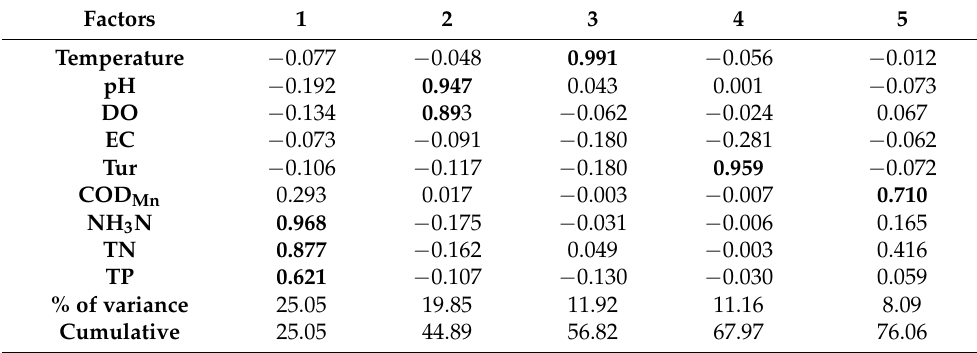
Table 2. Factor loadings of the water quality monitoring stations in